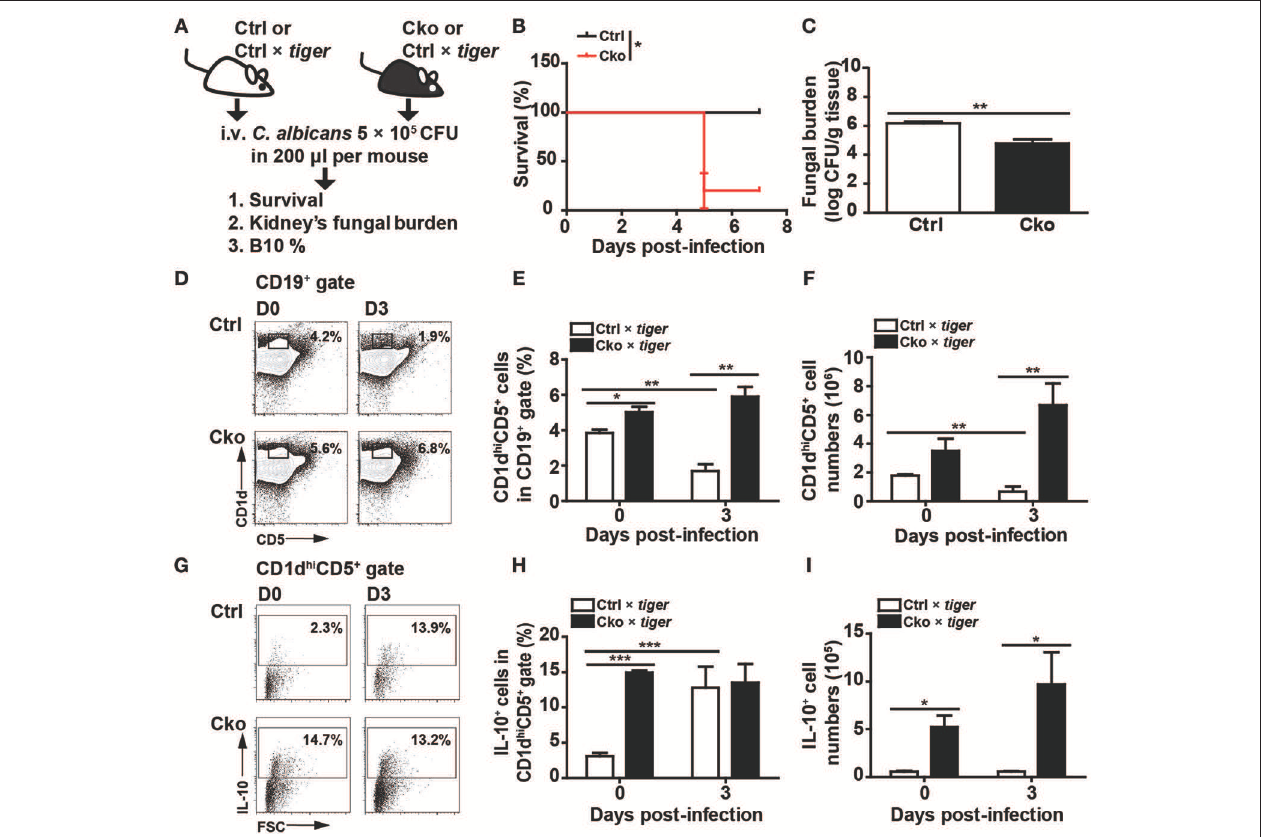
FIGURE 4 | Blimp-1-deficient mice had increased mortality in systemic candidiasis. (A) Schematic design for the infection of Ctrl, Cko, Ctrl × tiger , and Cko × tiger mice with 5 × 10 5 CFU of C. albicans by intravenous injection. (B) The survival rates of Ctrl and Cko mice were recorded ( n = 5 mice per group). The differences in survival rates were analyzed by a log-rank (Mantel-Cox) test. (C) Three days after infection, the fungal burden in the kidneys of Ctrl and Cko mice was quantified, and the resulting data are shown as the log10 value ( n = 4 mice per group). (D–F) The frequency (D,E) and numbers (F) of B10 cells in the Ctrl × tiger and Cko × tiger mice at day 3 post-infection. (G–I) The frequency (G,H) and numbers (I) of IL-10 + (GFP + ) B10 cells in the Ctrl × tiger and Cko × tiger mice at day 3 post-infection. Splenocytes were stimulated with LPS for 5h before cell surface staining ( n = 3 mice per group in D–I ). Results are from at least two independent experiments and were analyzed by using an unpaired Student’s t -test. Data are the mean ± SEM. * p < 0.05, ** p < 0.01, and *** p <